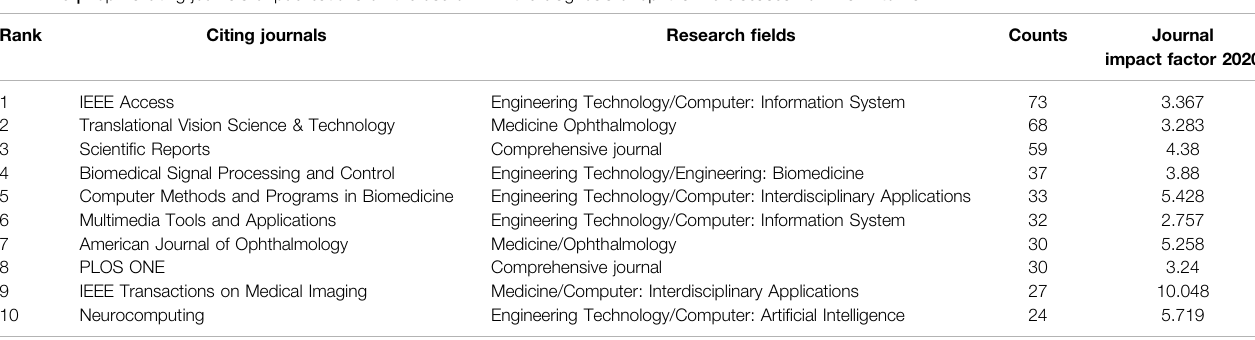
TABLE 3 | Top 10 citing journals of publications on the use of AI in the diagnosis of ophthalmic diseases from 2012 to 2021.